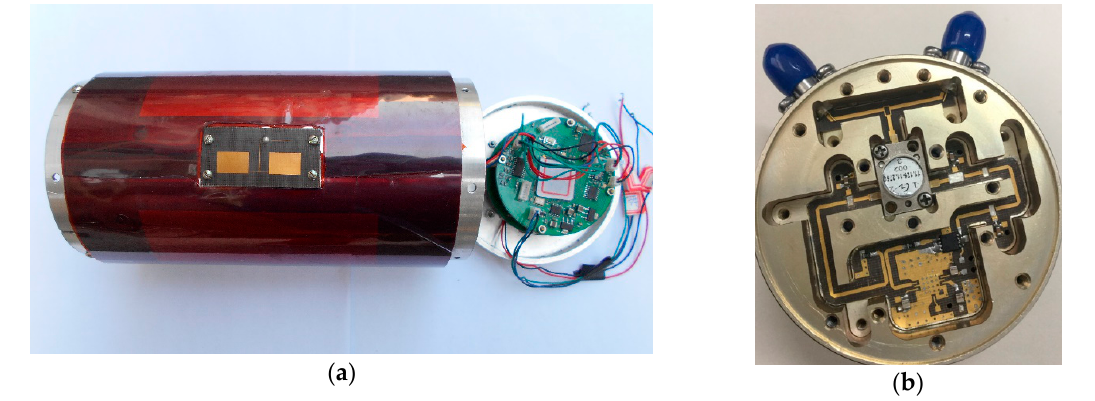
Figure 8. The designed anti-jamming sensor prototype . ( a ) The transceiver antenna and signal processing module, and ( b ) the RF module.